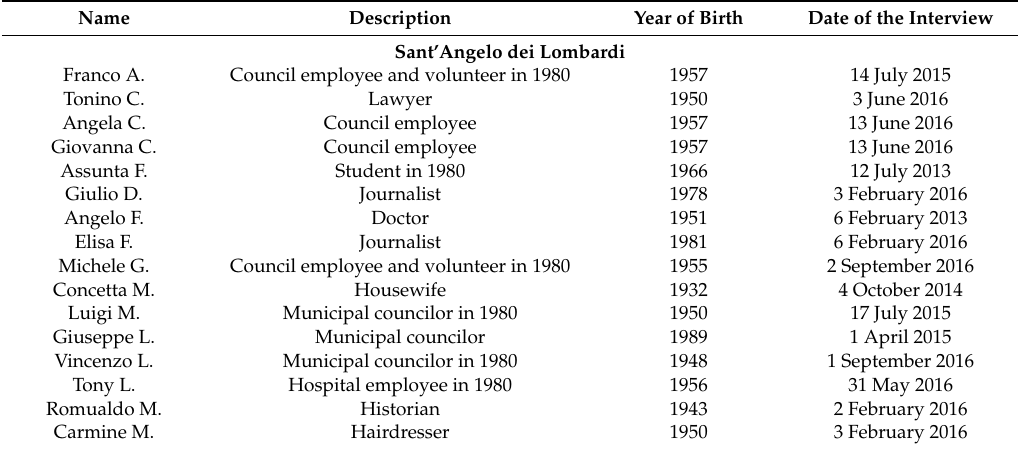
Table 1. List of witnesses with description, year of birth, and date of the